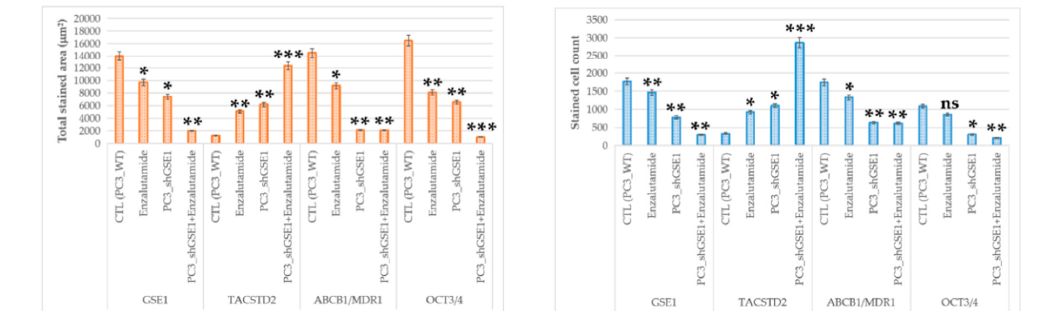
Figure 7. Targeting GSE1 signaling suppresses metastatic and cancer stemness phenotypes and enhances sensitivity to abiraterone or enzalutamide in metastatic castration-resistant prostate cancer in vitro and in vivo. ( A ) Representative Western blot images showing the differential expression of GSE1, TACSTD2, VIM, SNAI2, BAX, and BCL2 in PC3_WT, PC3_shGSE1, DU145_WT, and DU145_shGSE1 cells. GAPDH served as a loading control. ( B ) Histograms comparing PC3_WT, PC3_shGSE1, DU145_WT, and DU145_shGSE1 cell proliferation on Day 2 post-seeding. ( C ) Representative photomicrographs and histograms of migration by PC3_WT or PC3_shGSE1 over 24 h. ( D ) Representative images of the effect of shGSE1 on the formation of tumorspheres in PC3 or DU145 cell lines. ( E ) Line graphs showing the effect of 1.25–20 mg/mL Abiraterone ( upper ) or Enzalutamide ( lower ) on DU145_WT and DU145_shGSE1 cell viability. ( F ) Line graph showing the time-lapsed tumor volumes in mice inoculated with PC3_WT or PC3_shGSE1, with or without 10 mg/kg enzalutamide treatment. ( G ) Representative IHC staining photomicrographs ( upper left ), quantitative chart ( upper right ), total stained area histograms ( lower left ), and stained cell count histograms ( lower right ) of the differential expression of GSE1, TACSTD2, MDR1, and OCT3/4 proteins in tumor samples harvested from mice inoculated with PC3_WT or PC3_shGSE1, with or without 10 mg/kg enzalutamide treatment. CTL, control; WT, wild-type; * p < 0.05; ** p < 0.01; *** p < 0.001; ns, not significant.